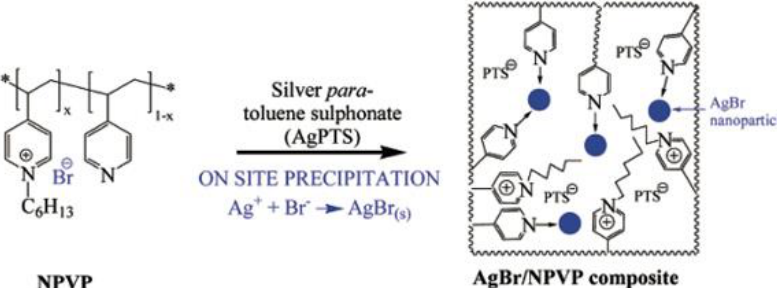
Figure 6. Schematic representation of the preparation of an antibacterial composite material, AgBr / NPVP (NPVP) poly(4-vinylpyridine)-co-poly(4-vinyl- N -hexylpyridinium bromide). Reproduced with permission from reference [94]. Copyright 2006